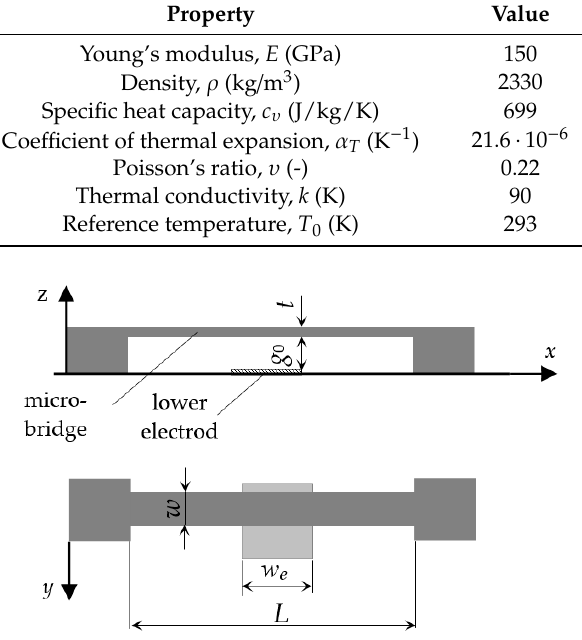
Figure 1. Schematic representation of a micro-bridge under electrostatic actuation.